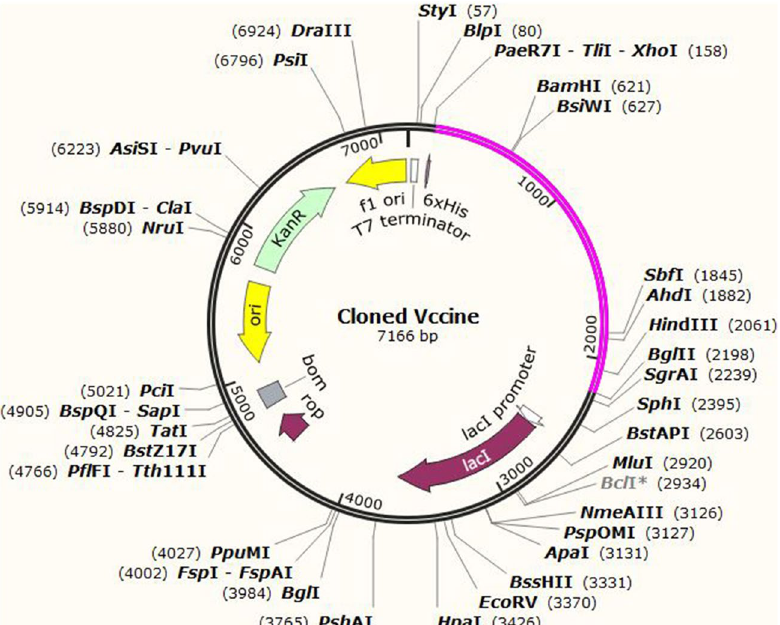
Figure 7. In silico cloning of the vaccine construct between Xho I and Bgl II restriction sites of pET-28a (+) vector using SnapGene sofware free-trial (https:// www. snapg ene. com/ free- trial/). The magenta part represents the vaccine sequence, while the black part represents the backbone of the pET28a (+)